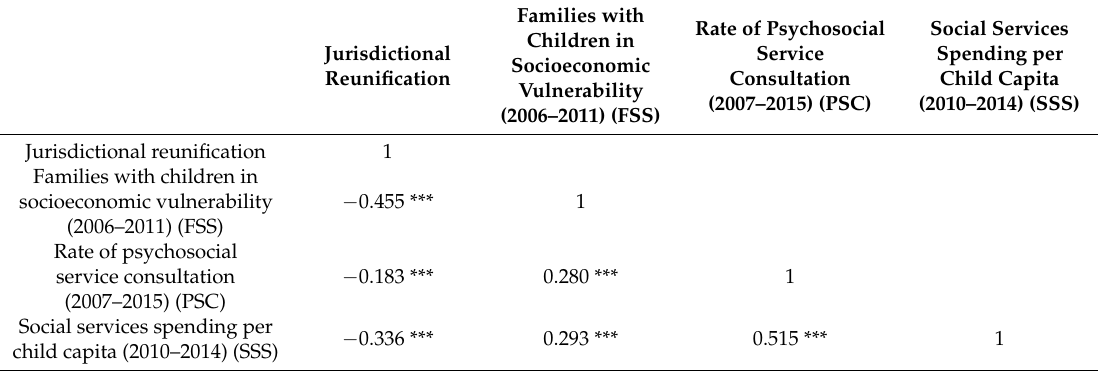
Table 2. Correlation between jurisdictional reunification, families with children in socioeconomic vulnerability, rate of psychosocial service consultations, and social services spending per capita.